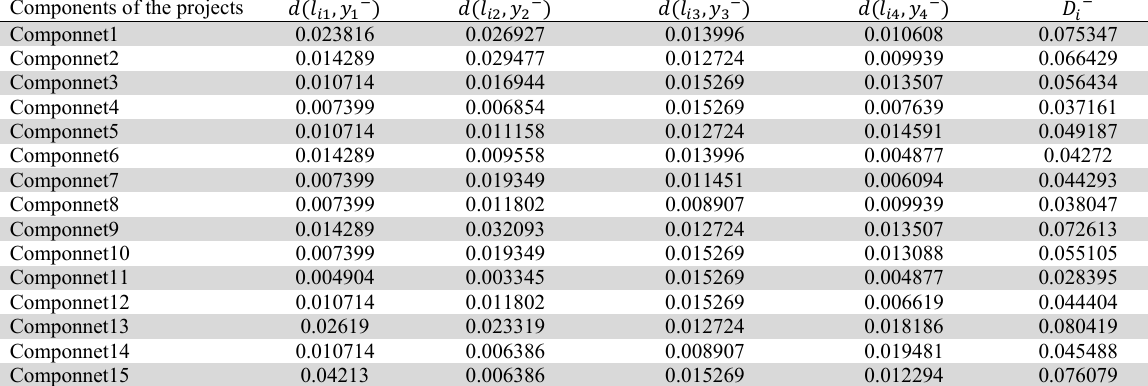
Distance from the negative solution Components of the projects